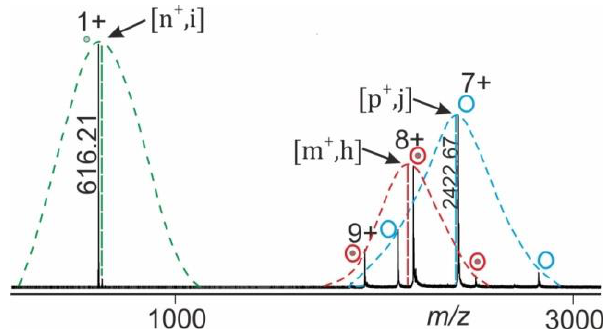
Figure 2. NanoESI mass spectrum of gas phase dissociation of protein complex (e.g., holo-myoglobin; apo-myoglobin—heme complex). Gaussian fits of ion intensities of the related charge state series for each molecular or supra-molecular species (complex) are shown (dashed charge state envelope curves). The arrows point to apices which are determined as maxima of fitted curves. The vertical dashed lines provide heights of charge structure envelopes which represent relative intensities of holo-protein complex ions (h, educts; red), ligand ions (i, product; green), and apo-protein ions (j, product; blue). Locations on the m/z axis match with mean charge states of holo-protein complex ions (m + , educts), ligand ions (n + , product) as well as apo-protein ions (p + , product). Mean charge states of each ion species, e.g., holo-protein ions (educts) and of apo-protein as well as of ligand ions (products) can be separately determined from the mass spectrum. Normalization of ion intensities is achieved by summation of all apex values and setting the sum to 100% (equations and calculations are shown in the supplemental